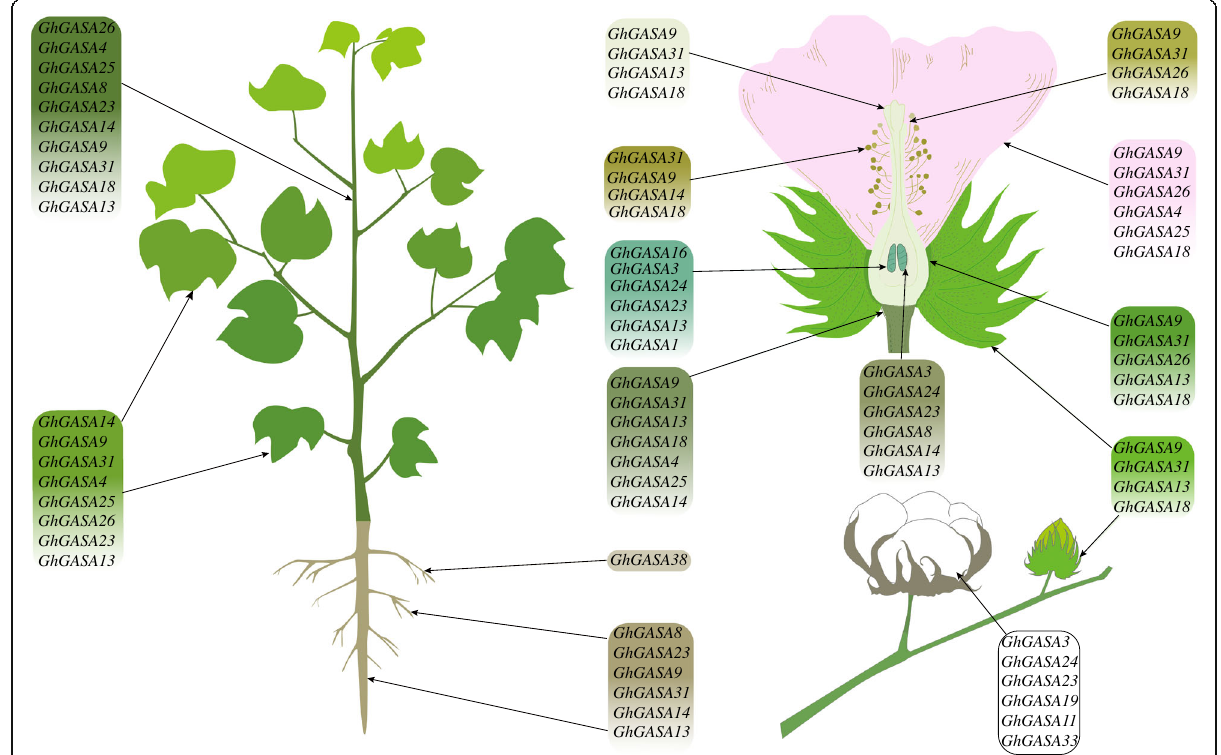
Fig. 7 Summary chart for cotton and the expression locations of the GhGASA genes. Different colors indicate different tissues. The degree of GhGASA expression is represented by a graduated